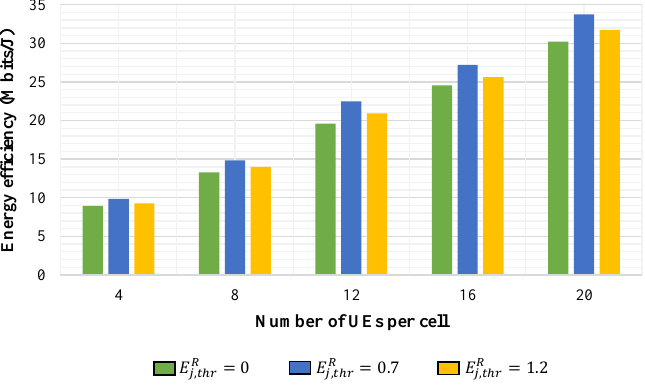
= 10 dB and E HC M S